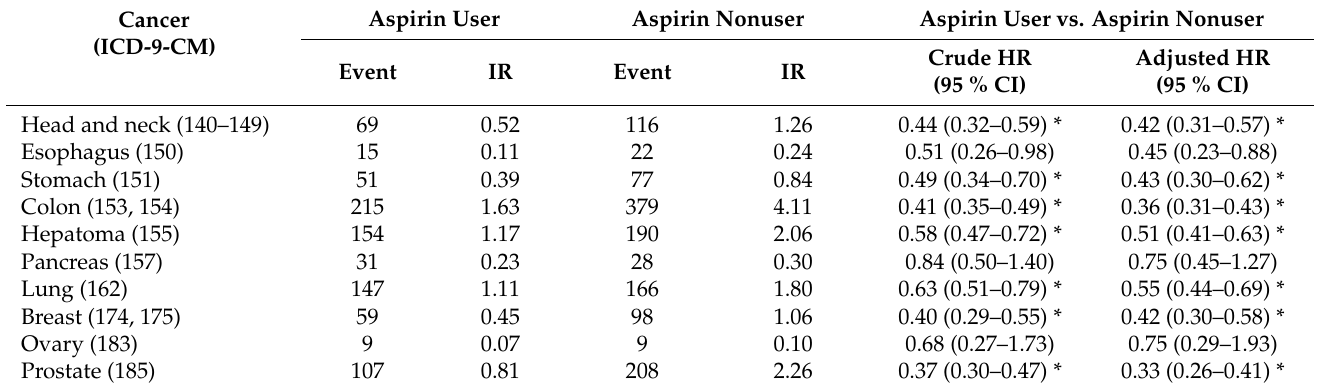
Table 4. Incidence rate and risk of developing primary cancer in ICCD survivors stratified by various types of